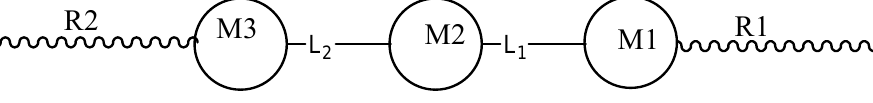
Figure 2. Model represents typical feature of calamitic liquid crystals, R1 & R2 are terminal groups, M1, M2 & M3 are ring systems, and L1 & L2 are linking